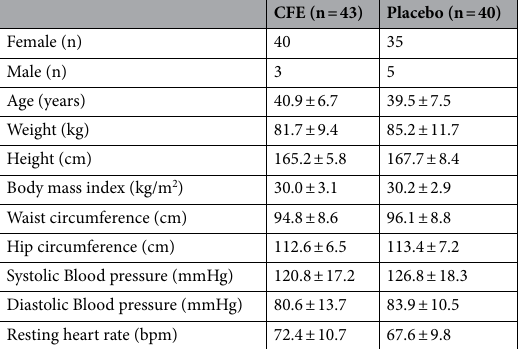
Table 1. Baseline participant demographics. Data presented as mean ± SD; CFE, Caralluma fimbriata ; bpm, beats per